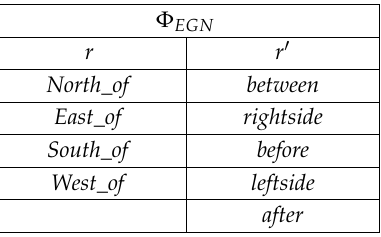
Figure 3. Taxonomy of frames of reference (figure taken from [21]).